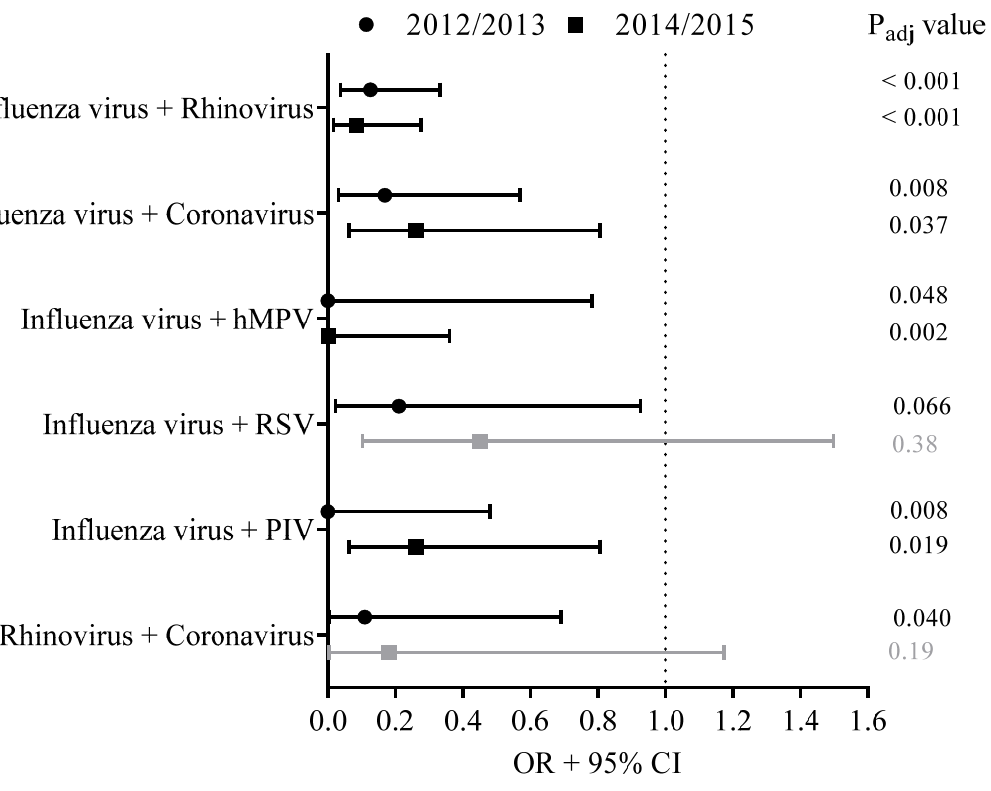
Figure 3. A calculation was made whether a specific virus co-infection appeared to occur less often than expected based on the frequency of the detected single pathogens in season 2014–2015 (squares). For comparison, the occurrence of viral co-infections in 2012–2013 was studied as well (circles). Results of these analyses are presented as the OR of the odds of being infected with pathogen A when already infected with pathogen B compared to the odds of being infected with a singular pathogen A. The 95% CI, presented as bars, was used to estimate the precision of the OR. Adjusted p -values ( p adj ) were calculated, and p adj < 0.10 was considered as significantly different (indicated with black lines), p adj > 0.10 was considered as not significantly different (indicated with grey lines).